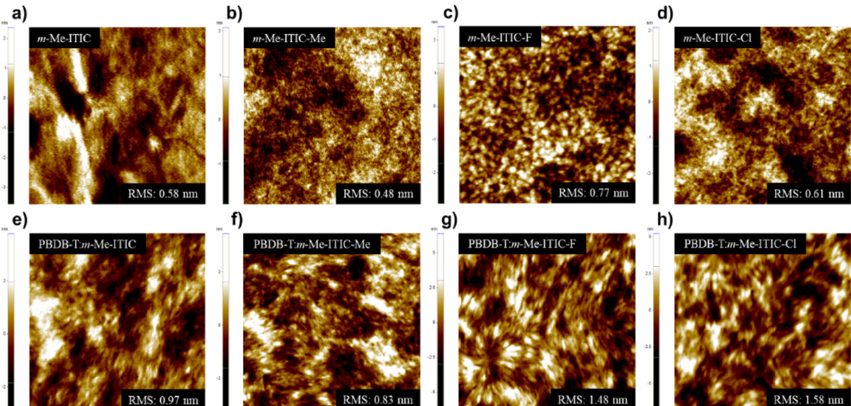
Figure 3. Atomic force microscopy (AFM) height images of ( a ) m-Me-ITIC, ( b ) m-Me-ITIC-Me, ( c ) m-Me-ITIC-F, ( d ) m-Me-ITIC-Cl, ( e ) PBDB-T: m-Me-ITIC, ( f ) PBDB-T: m-Me-ITIC-Me, ( g ) PBDB-T: m-Me-ITIC-F, and ( h ) PBDB-T: m-Me-ITIC-Cl.